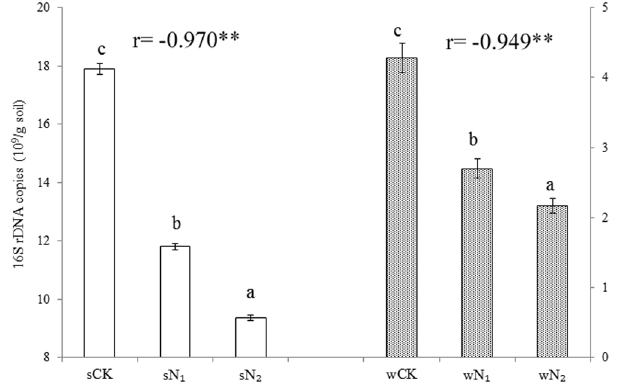
Figure 1. Abundance of bacteria as indicated by the numbers of 16S rDNA copies measured using quantitative PCR. sCK, sN 1 and sN 2 indicate different N treatments in the soybean season; wCK, wN 1 and wN 2 indicate different N treatments in the wheat season. The ‘r’ indicates Pearson’s correlation coefficient between N added and 16S rDNA copies ( ** P < 0.01, * P <